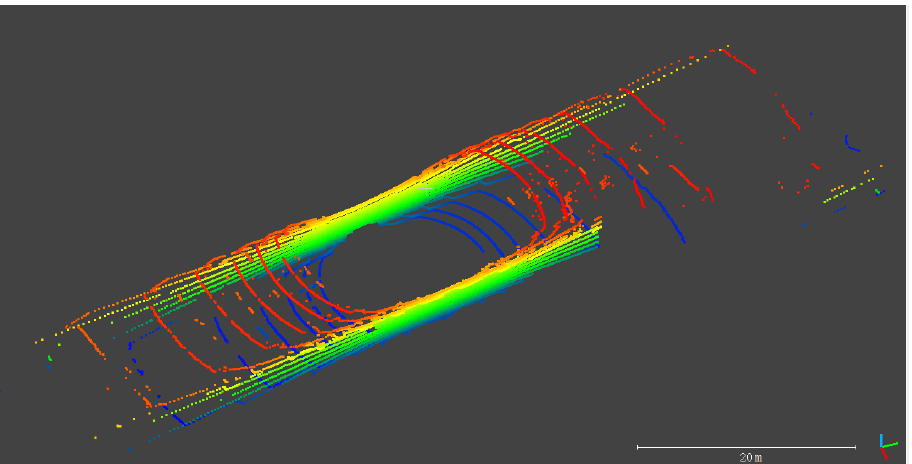
Figure 1. Point clouds in the tunnel colored by the height.